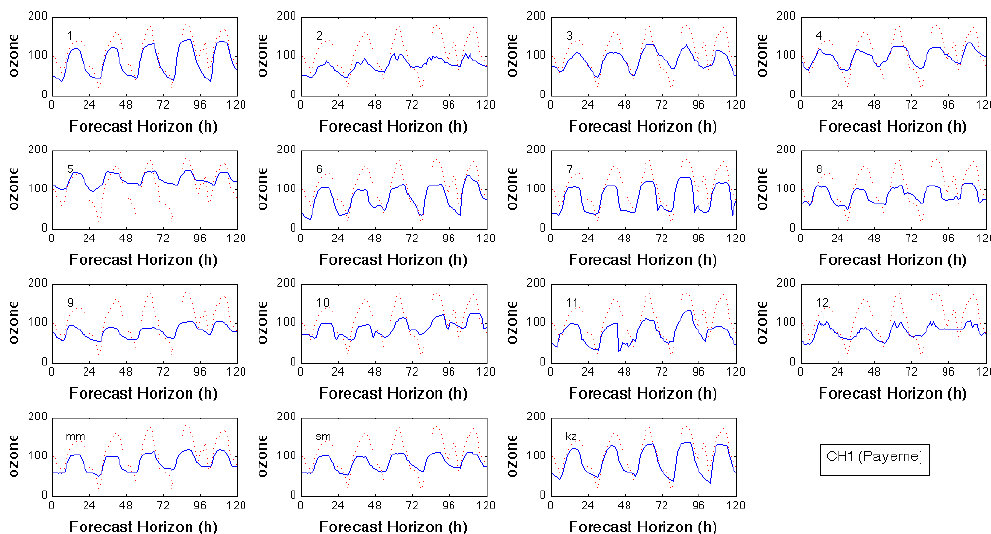
Fig. 14b. Indicative results at the station level. (b) Time-series of ozone predictions for the Payerne station during the week with the highest levels. The persistence assumption was true only for the DU